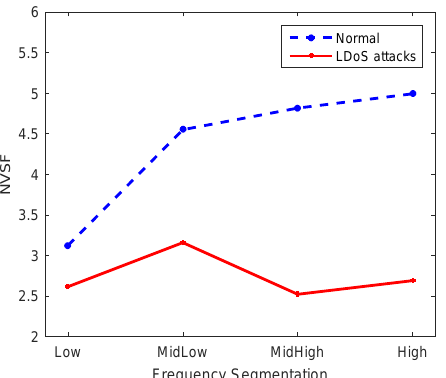
Figure 6. Normalized variance of segmentation frequency comparison.